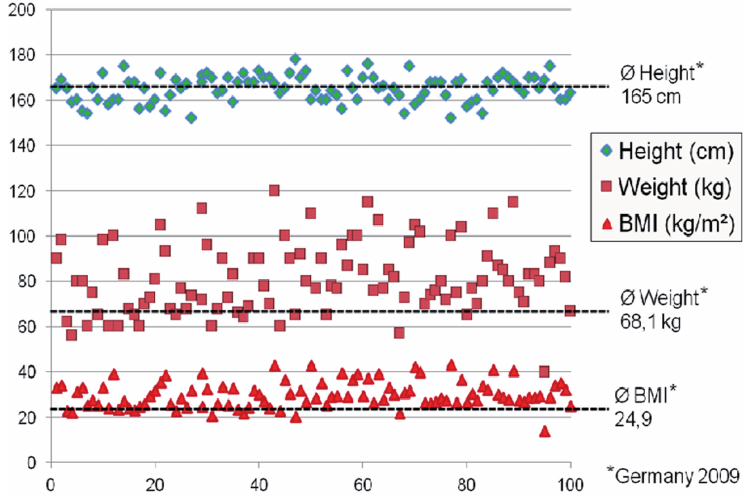
Figure 2 - Age ranged from 43 to 86 years (mean 70.3 years). The body-mass-index (BMI) of the patients is predominantly clear above the German